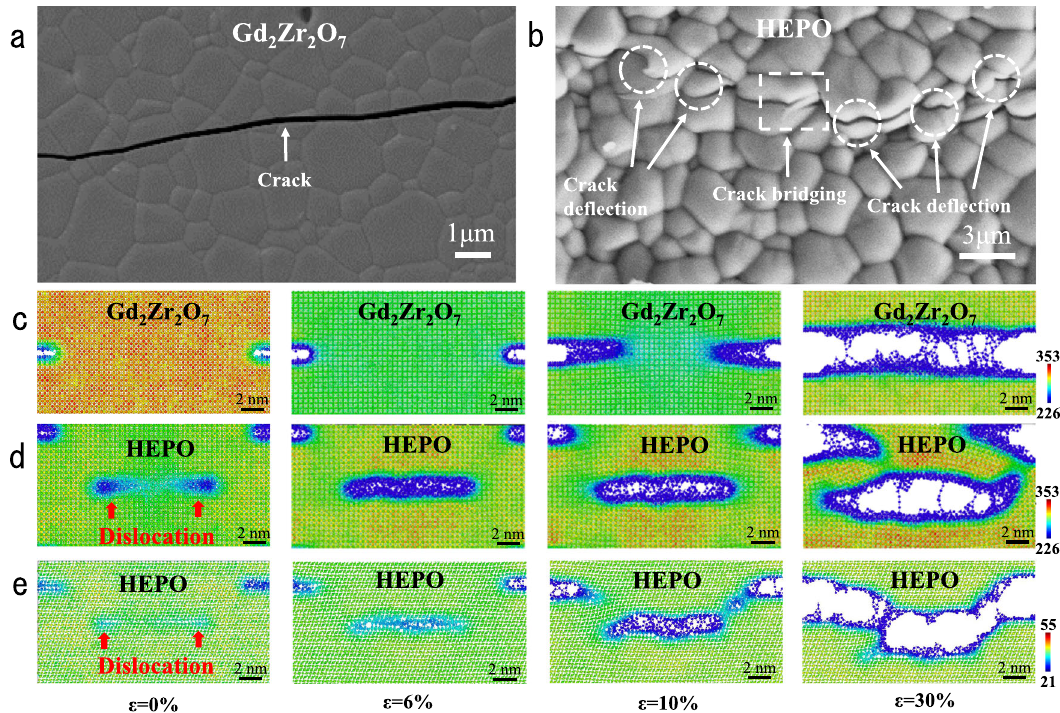
Fig. 5 Coordination number distribution in Gd 2 Zr 2 O 7 and Ca 1.2 Gd 0.8 Zr 0.8 Nb 0.6 Ta 0.6 O 7 (HEPO) during crack propagation along with the experimental observations. a , b The surface crack propagation path in Gd 2 Zr 2 O 7 and HEPO samples; c Straight and brittle crack propagation in Gd 2 Zr 2 O 7 crystal; d Crack bridging in HEPO interacting with two edge dislocations; e Crack de fl ection in HEPO interacting with two edge dislocations. Dislocations are indicated by red arrows. The color scale denotes the coordination number of each cation (unit: counts).